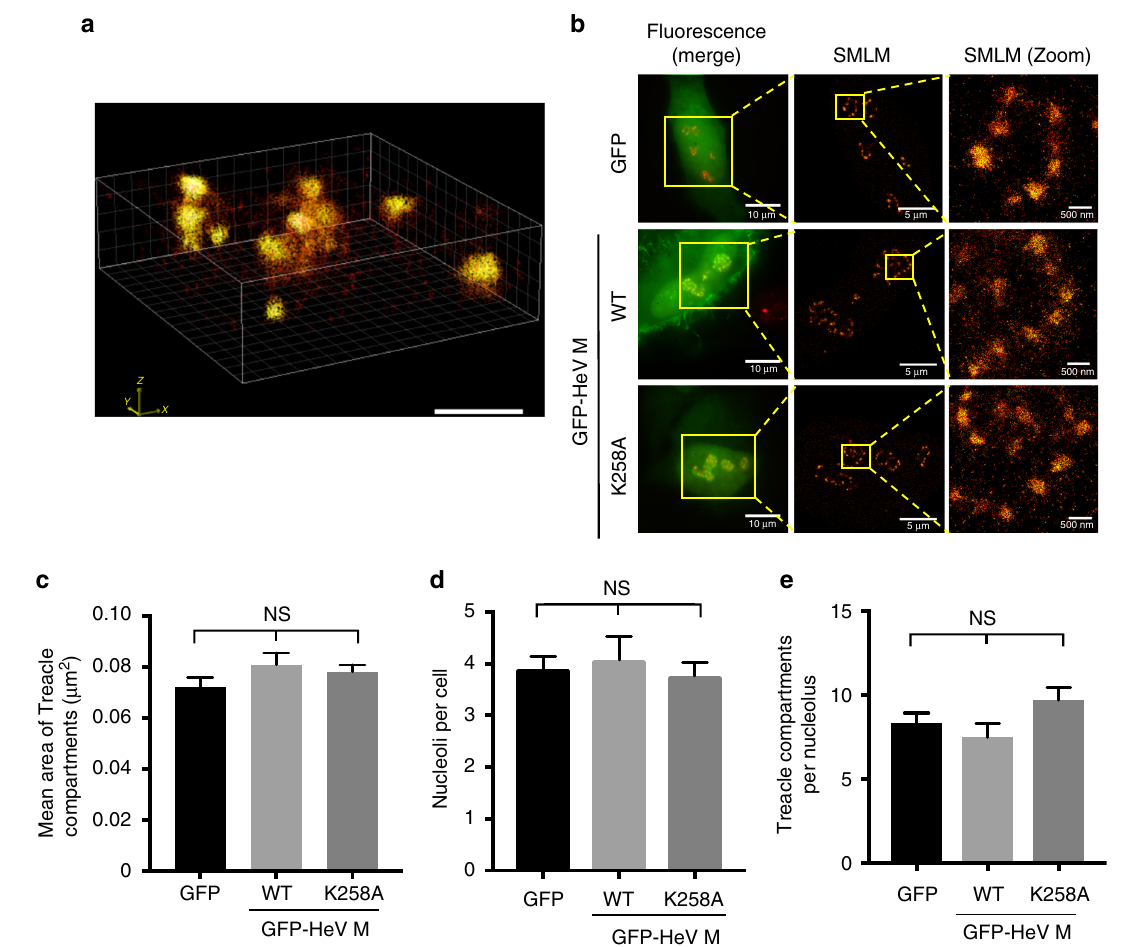
Fig. 5 HeV M protein expression does not impact the structure or distribution of Treacle-enriched compartments. HeLa cells expressing GFP alone ( a ) or the indicated proteins ( b ) were fi xed and immunolabeled for Treacle before analysis. a d STORM single molecule localization microscopy (SMLM) was used to generate 3D images of Treacle-enriched subnucleolar compartments. Scale bar indicates 1 μ m. b Fluorescence microscopy was used to identify cells expressing GFP (green) and immunostained for Treacle (red/yellow in merged image), which were then analyzed by SMLM to detect Treacle. Scale bars correspond to the indicated sizes. c – e Images such as those shown in Fig. 5b were used to determine ( c ) the area of Treacle-enriched compartments (mean ± s.e.m., n ≥ 427 compartments), ( d ) the number of nucleoli per cell (mean ± s.e.m., n ≥ 14 cells), ( e ) the number of Treacle-enriched compartments per nucleolus (mean ± s.e.m., n ≥ 57 nucleoli). Statistical analysis used Student ’ s t -test; NS not signi fi cant